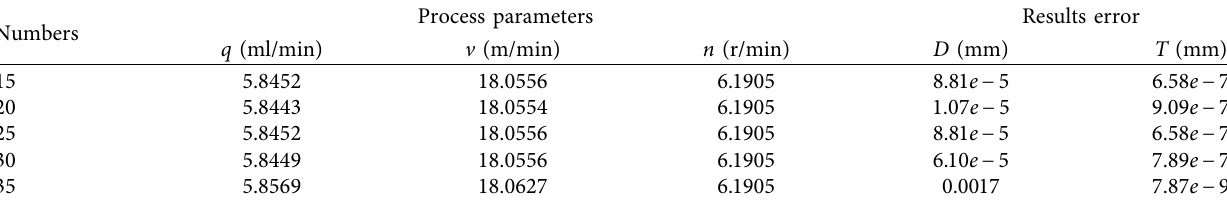
Table 4: Five optimal solutions of target size (1, 0.15).